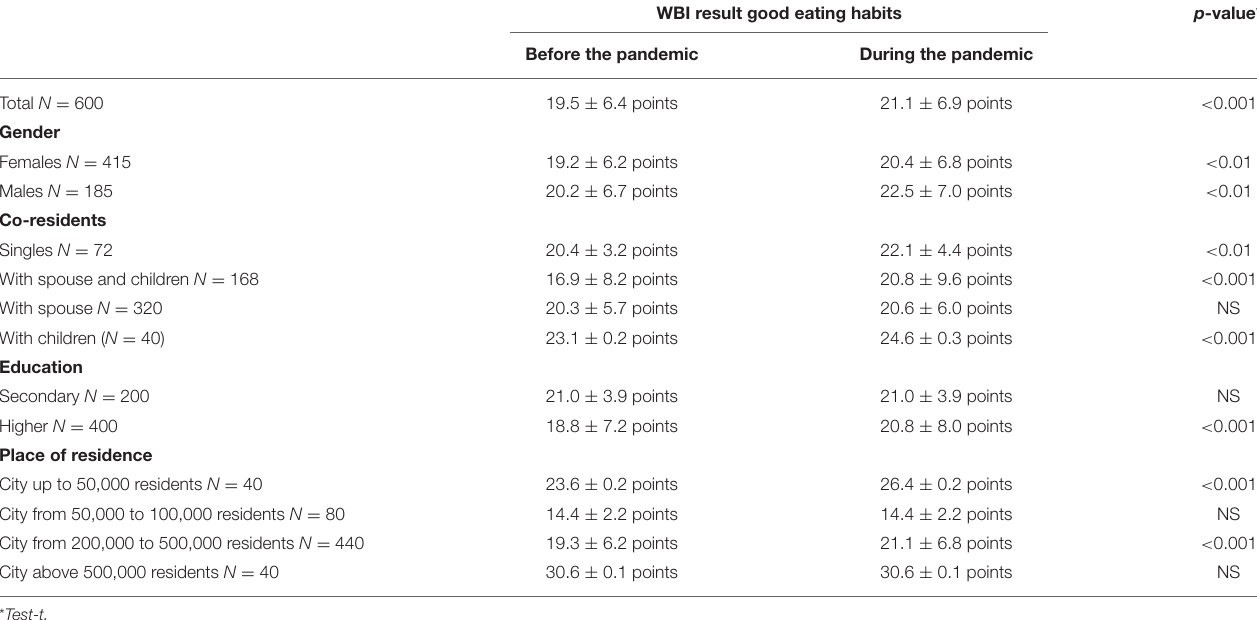
TABLE 6 | Assessment of good eating habits among the respondents before and during the pandemic by gender, education, co-residents, and place of residence.